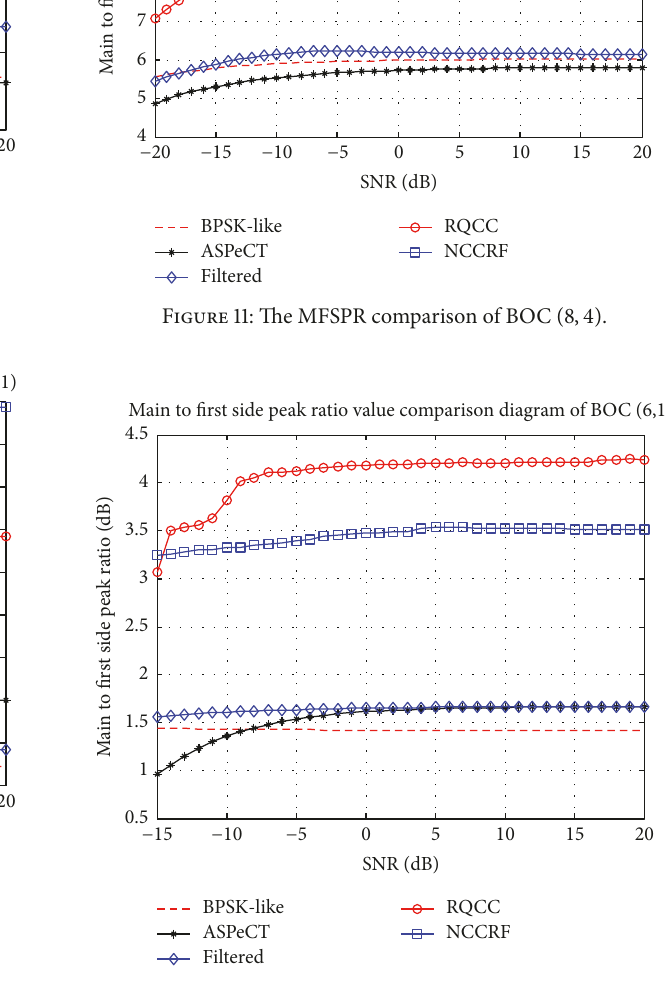
Figure 12: The MFSPR comparison of BOC ( 6, 1